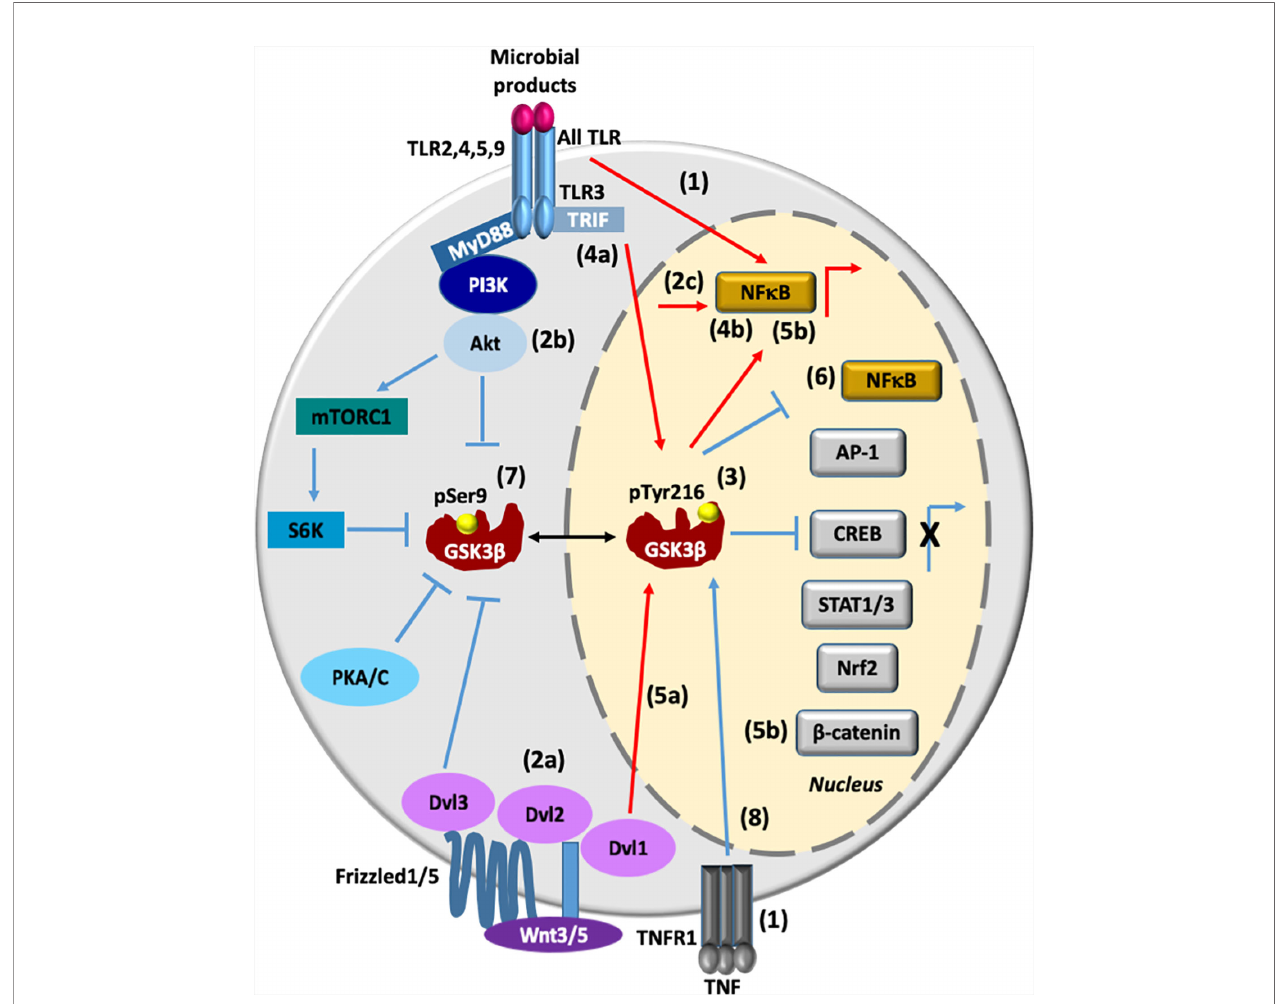
FIGURE 1 | GSK3 b transcriptionally regulates pro- and anti-in fl ammatory responses. (1). All TLR and TNFR1-associated intracellular signaling promote transcriptional activation of NF- k B. (2a-c) Wnt3/5/Dvl2/Akt signaling also promotes activation of NF- k B. (3) The active state of phosphorylated GSK3 b at Tyr216 (GSK3 b pTyr216) promotes the activation of NF- k B and at the same time it promotes the inhibition of AP1, CREB, STAT1/3, Nrf2, and b -catenin, leading to proin fl ammatory cytokines production. (4a, b) During viral infection, TLR3/TRIF/GSK3 b signaling pathway positively regulates both pro-in fl ammatory cytokines and IFN- b production through NF- k B and AP-1 activation and IRF3 activation, respectively. (5a, b) Activation of the canonical Wnt signaling pathway enhances activation of GSK3 b , thus in fl uencing b -catenin degradation and NF- k B activation (6). Overexpression of GSK3 b inhibits NF- k B transcriptional activity. (7) Upon the activation of TLR (2, 4, 5, or 9)/MyD88/PI3K/Akt signaling, GSK3 b is inhibited by phosphorylation at Ser9 (pSer9), leading to an anti-in fl ammatory response. GSK3 b is also phosphoinhibited by S6K, PKA/C, and Dvl3 proteins. (8) TNF induces an increase in the nuclear expression of GSK3 b and GSK3 b promotes anti-in fl ammatory responses by mediating expression of the signaling inhibitors that terminate TLR4-induced NF- k B signaling, and by suppressing chromatin remodeling. Lines in red denote a proin fl ammatory response, while lines in blue denote an anti-in fl ammatory response. AP-1, activator protein 1; IRF3, interferon regulatory factor 3; CREB, cAMP-response element binding protein; NF- k B, nuclear factor kappa-light-chain-enhancer of activated B cells; Nrf2, nuclear factor erythroid 2-related factor 2; PI3K, phosphoinositide 3-kinase; PKA/C, protein kinase A/C; PKB, protein kinase B, also known as Akt; STAT1-3, signal transducers and activators of transcription 1-3; S6K, ribosomal protein 6 kinase; TLR2, 4, 5, 9, Toll-like receptor 2, 4, 5 and 9; TNFR, tumor necrosis factor receptor; Wnt5, wingless-related integration site member 5:: dishevelled segment polarity protein 1, 2 and 3 (Dvl1/2/3). Lipoproteins (TLR2 ligand), LPS (TLR4 ligand), fl agellin (TLR5 ligand), bacterial CpG DNA (TLR9 ligand) and viral double-stranded RNA (TLR3